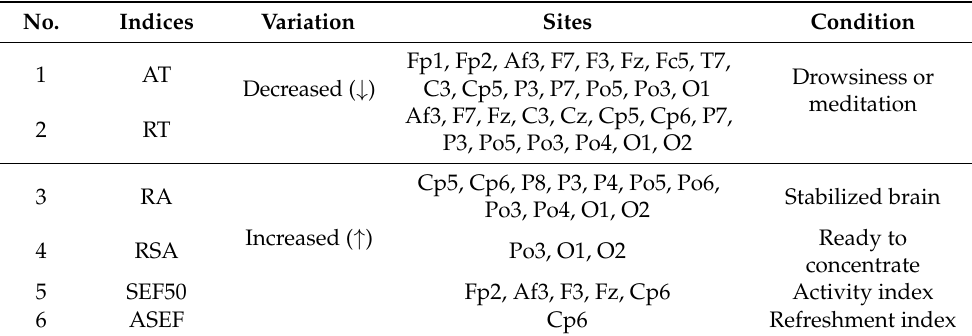
Table 2. Overall significant decreases and increases in EEG activity during exposure to A. rugosa essential oil.